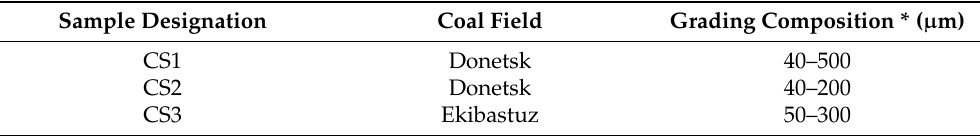
Table 1. Source designation and granulometric composition of